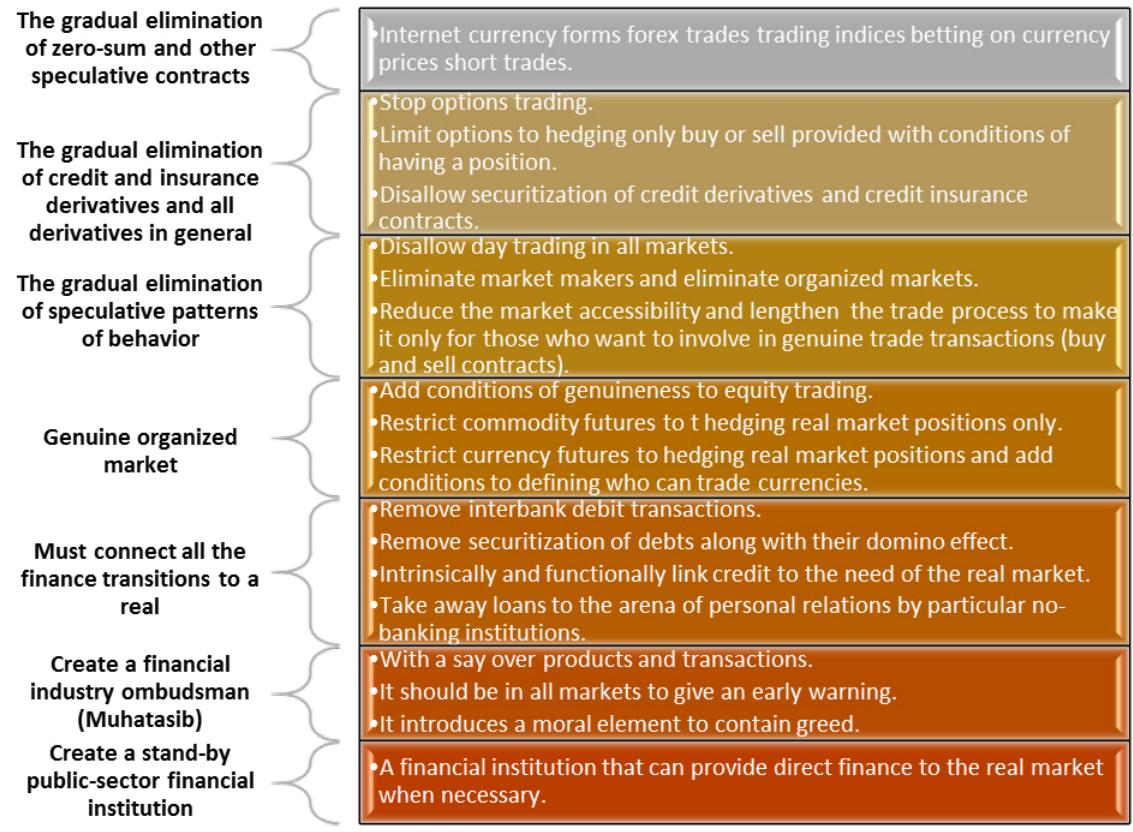
Figure 1: Islamic Finance Instruments and Their Role in the